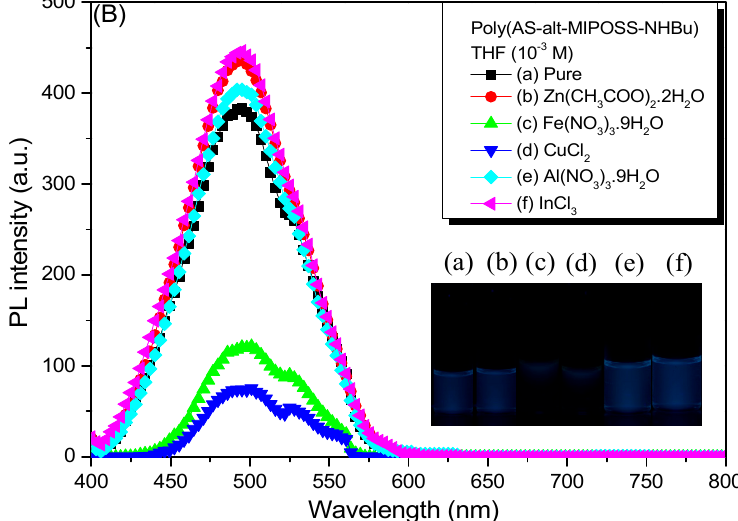
Figure 15. Fluorescence spectra (excitation: 330 nm) of the copolymer poly(AS- alt -MIPOSS-NHBu) (concentration: 10 − 3 M) in the presence of various metal ions: ( a ) pure MIPOSS-NHBu; ( b ) Zn(CH 3 COO) 2 ·2H 2 O; ( c ) Fe(NO 3 ) 2 ·9H 2 O; ( d ) CuCl 2 ; ( e ) Al(NO 3 ) 3 ·9H 2 O; and ( f ) InCl 3 .